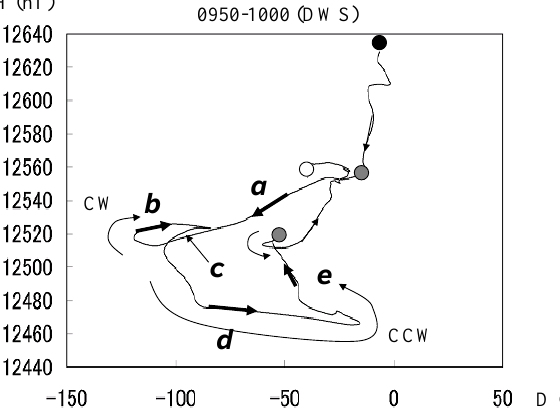
Figure 12. Hodogram of the polarization ellipses on the D − H plane for the interval 09:50–10:00UT. The plot starts from the black circle and ends at the white circle. The polarization ellipse between the gray circles was caused by characteristic changes of the field vectors, 1 to 4 in H , and a to e in D in Fig. 8. The arrows mark the field line changes associated with a to e in D .